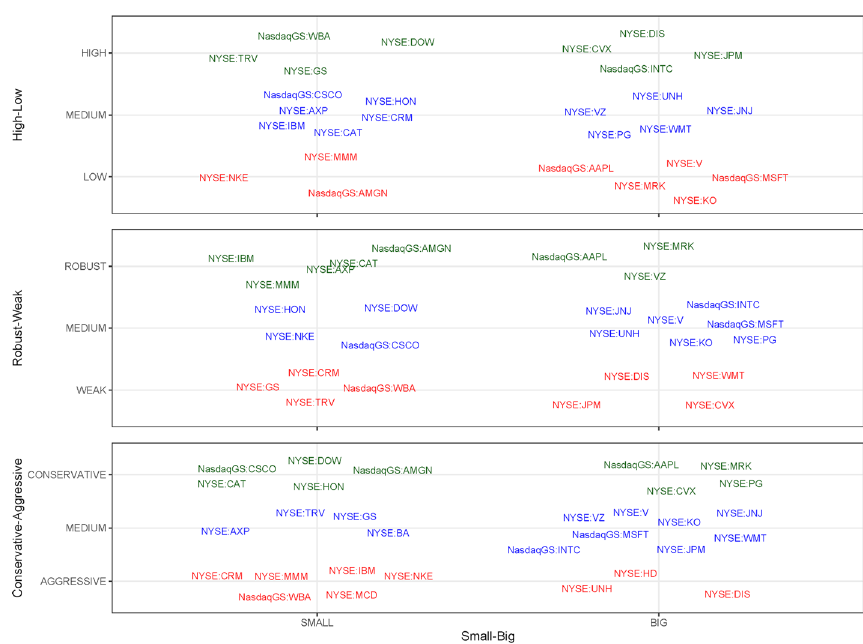
Fig. 12 Portfolio classification using R. Source : Created by authors